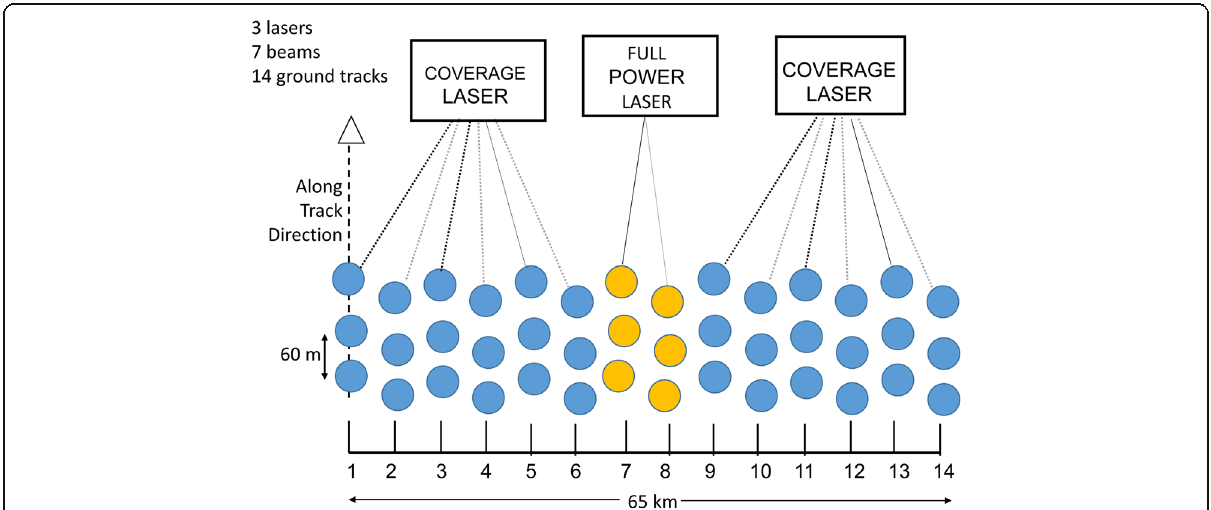
Fig. 21 This diagram shows the pulse density and sampling patterns of the GEDI lasers. Each laser pulse produces a full waveform (based on all returns from the pulse) which is used to capture the full 3-D vertical structure from the ground to the tallest point. Redrawn from NASA, https://directory.eoportal.org/web/eoportal/